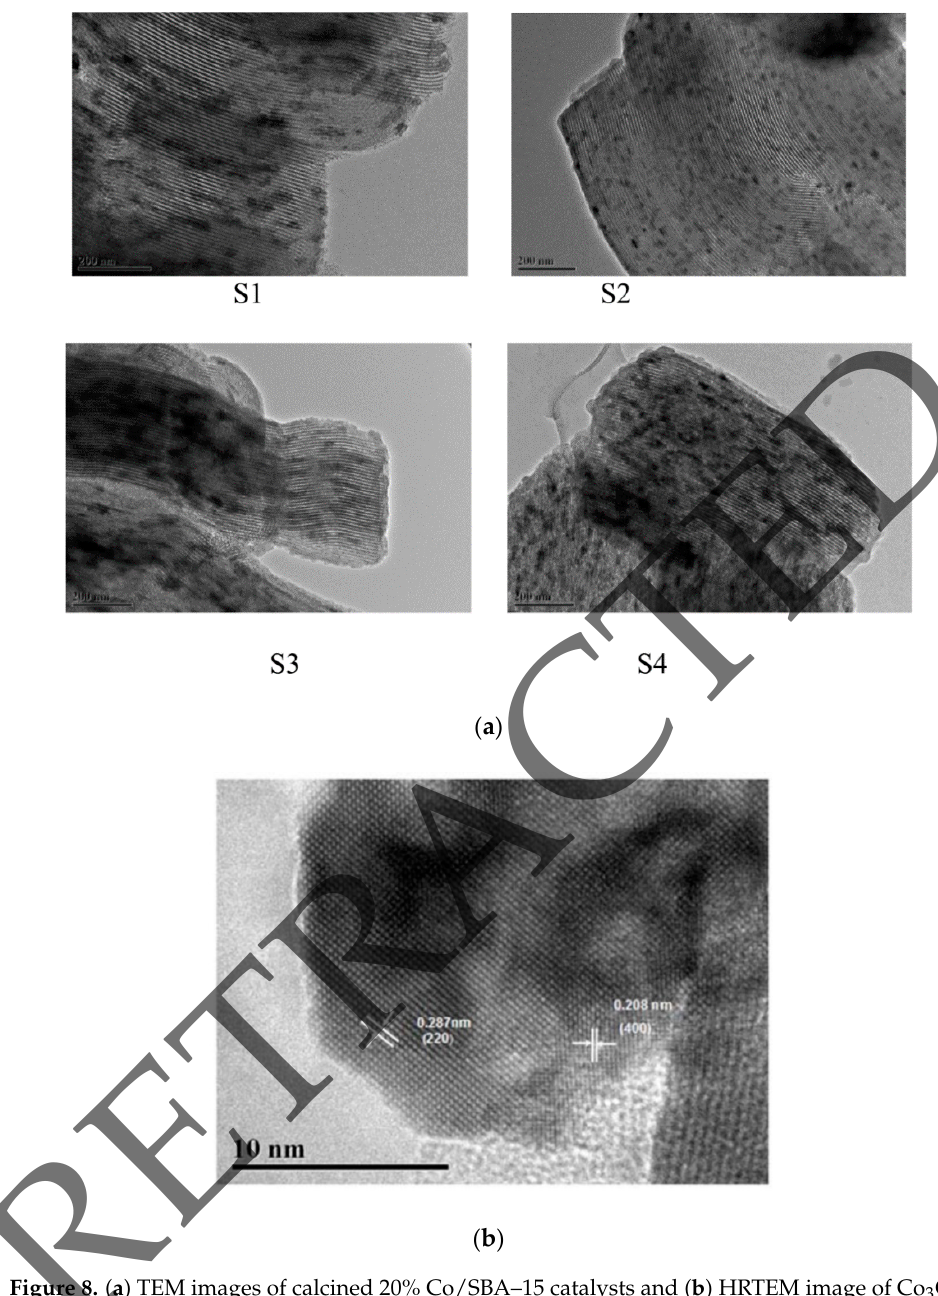
Figure 8. ( a ) TEM images of calcined 20% Co/SBA–15 catalysts and ( b ) HRTEM image of Co 3 O 4